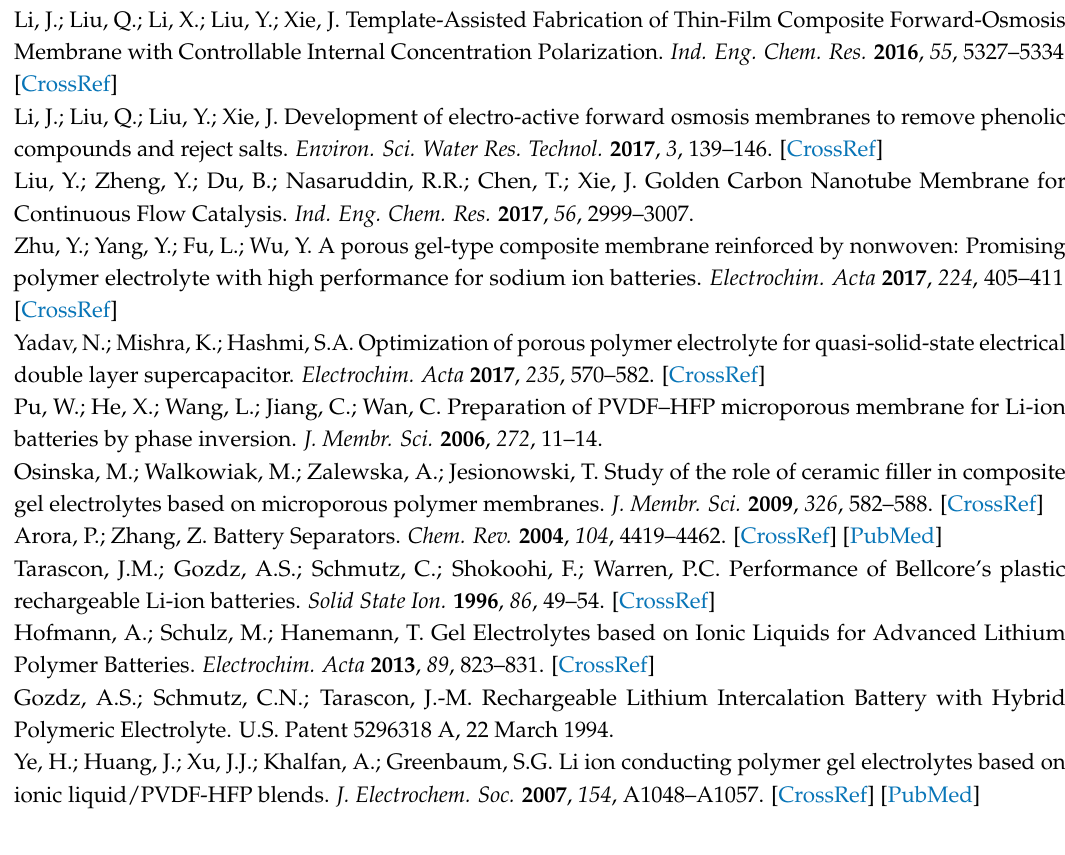
Figure S1: Illustration of the double spheres of PVdF-HFP based on the HSPiP software, Figure S2: Projection of the Hansen sphere in the dD-dP dimension, Figure S3: Projection of the Hansen sphere in the dP-dH dimension, Figure S4: SEM images of membrane M-1, Figure S5: SEM images of membrane M-2. Table S1: Hansen solubility parameter of selected solvents, Table S2: Comparison of software fitting and proposed fitting method, Table S3: Safety properties of chemicals according to safety data sheets taken from Bernd Kraft GmbH, Table S4: Comparison of experimental and calculated solubility. Solubility of PVdF-HFP in selected solvent mixtures based on